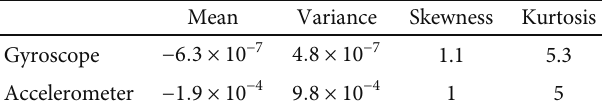
Table 2: Random noise error